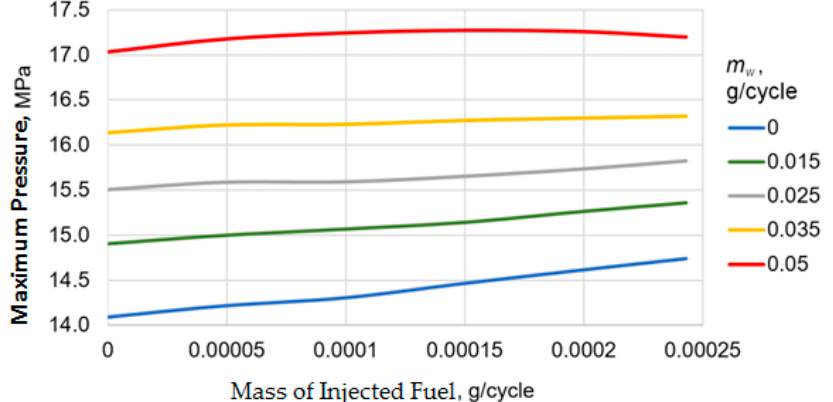
Figure 10. Dependence of the maximum pressure of gases in the combustion chamber on the cyclic supply of fuel and water ( m w ) to the intake manifold. (Source: Authors).